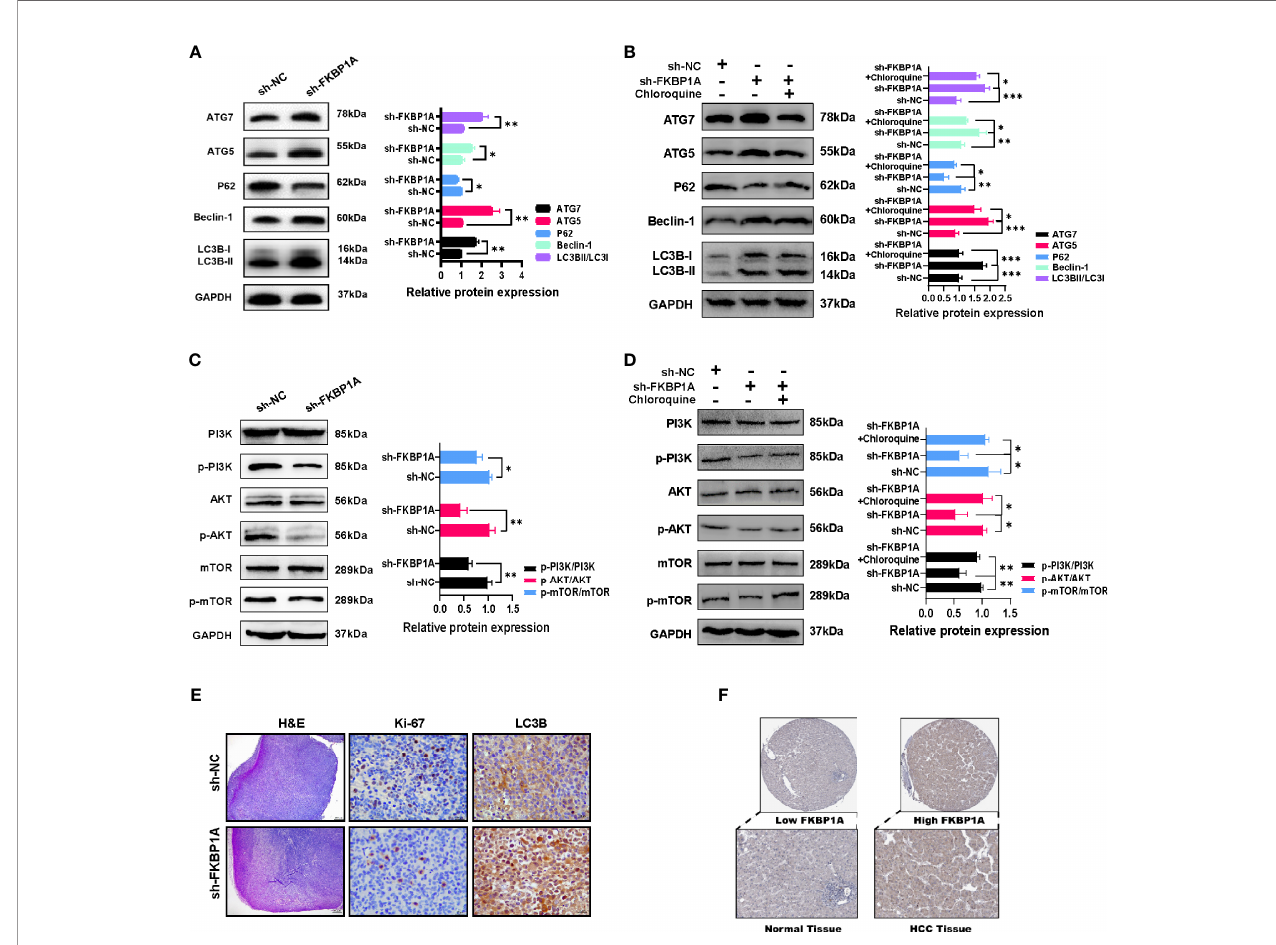
FIGURE 10 | The inhibition of autophagy by sh-FKBP1A in HCC cell lines and mice. (A, B) Western blot analysis showing the levels of autophagy-related proteins in FKBP1A knockdown cells treated with or without chloroquine (10 µM). (C, D) Western blot results and analysis of mTOR, p-mTOR, PI3K, p-PI3K, AKT, and p-AKT levels in different groups treated with or without chloroquine (10 µM). (E) Histopathological changes were examined using H&E staining (bar = 200 m m). Expression levels of Ki-67 and LC3B in tumor tissues were detected using immunohistochemistry (bar = 20 m m). The presence of brown granules in the nucleus or cytoplasm was considered positive staining for target proteins. (F) IHC staining for FKBP1A in liver cancer and normal liver tissues. *p < 0.05, **p < 0.01 and ***p < 0.001. Data are presented as the means ± SD (n ≥